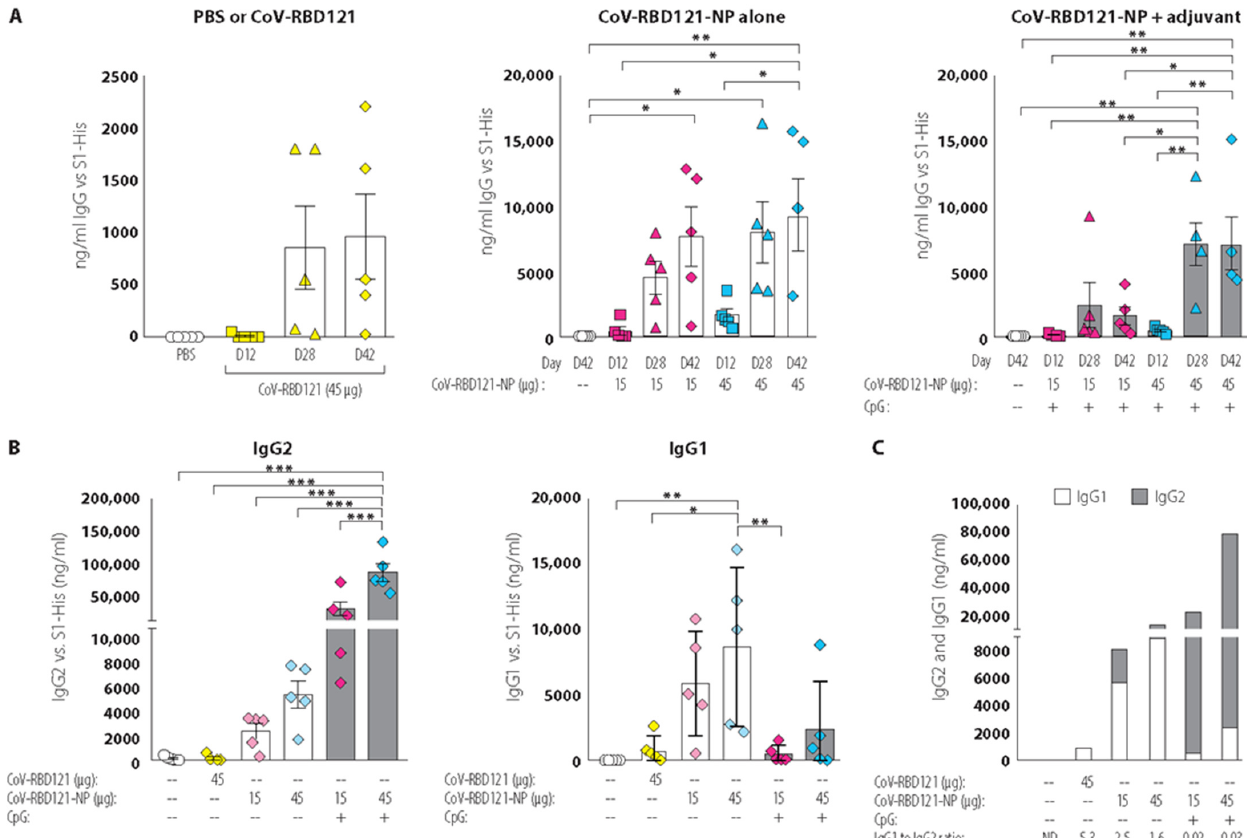
Figure 4. Immune response to CoV-RBD121 or CoV-RBD121-NP with or without adjuvant. ( A ) Concentration of IgG recognizing S1-His in sera from mice administered the indicated antigen or vaccines. CoV-RBD121 is the antigen alone, CoV-RBD121-NP is the TMV-conjugated NP vaccine. Sera were collected on day 12 (D12) after the first dose, and on day 28 (D28), 14 days after the second injection dose. Terminal sera were collected on day 42 (D42), 28 days after boosting. For mice receiving PBS, data for sera collected on day 42 are shown. ( B ) Concentration of IgG2 (left) and IgG1 (right) recognizing S1-His in sera collected from mice on day 42 administered the indicated antigen or vaccines. ( C ) Stacked bar graph shows the amount of IgG1 and IgG2 antibodies recognizing S1-His, which were used to calculate the ratio of IgG1 to IgG2. Significant differences among the groups were determined by one-way ANOVA with Tukey’s correction for multiple comparisons ( n = 4–5 mice per group as indicated; * p ≤ 0.05; ** p ≤ 0.01; *** p ≤ 0.001). Colors are coordinated to indicate individual values for mice immunized with PBS (clear); CoV-RBD121 antigen alone (yellow); 15 mcg CoV-RBD121-NP (magenta); and 45 mcg CoV-RBD121-NP (blue) at day zero (circles), Day 12 post vaccination (squares), Day 28 post vaccination (triangles) and Day 42 post vaccination (diamonds).